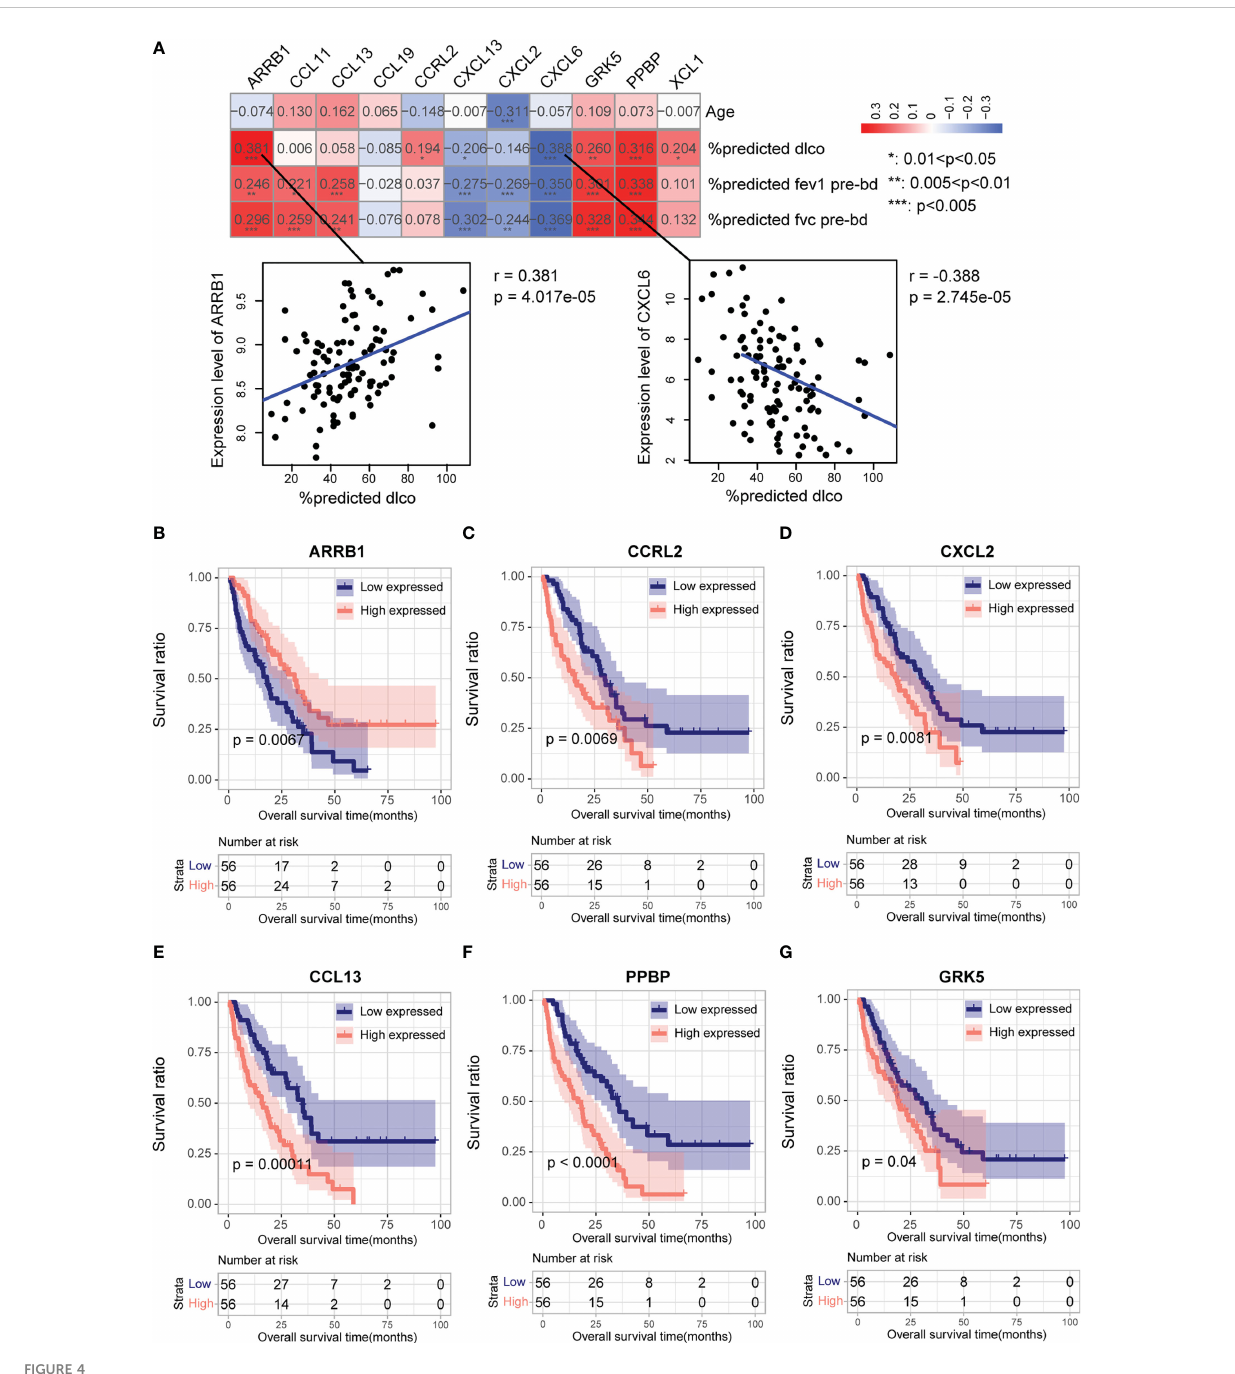
FIGURE 4 Association of clinical parameters and prognostic value of eleven CR-DEGs in IPF patients. (A) Correlation between eleven CR-DEGs and age, dlco, fev1, and fvc. (B – G) . K-M analysis and the predictive value of ARRB1 (B) , CCRL2 (C) , CXCL2 (D) , CCL13 (E) , PPBP (F) , and GRK5 (G) for the survival in the BALF of patients with